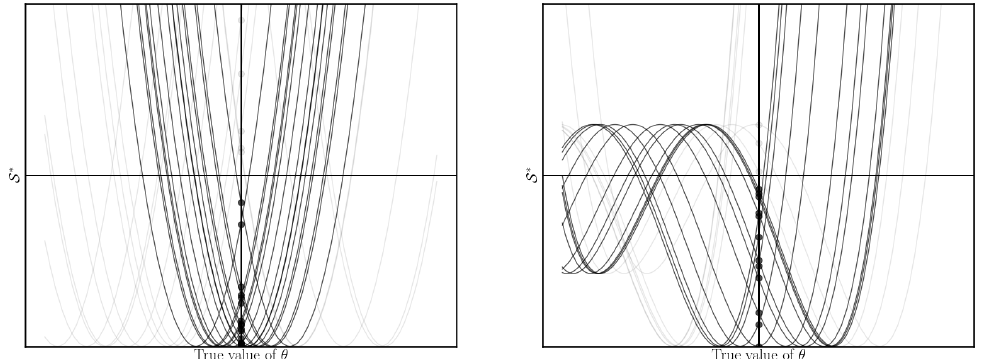
Figure 8. Evolution of the statistic S as a function of the model parameter θ from different pseudo- experiments with fixed true value ¯ θ . Vertical line shows the true value of θ , while the horizontal one shows the threshold S ∗ for the statistic such that S ( ¯ θ ) ≤ S ∗ only x % of the time. Black curves are those that fulfill this condition while grey ones are those that do not. In the left plot the intersection between the curves and the line S = S ∗ defines CIs which by construction cover the true value of θ x % of the time. These CIs cannot be anymore constructed for the curves in the right plot where the statistic has below S ∗ more than one minimum. In both plots the curves shown are not specific on any particular problem but only serve as a schematic